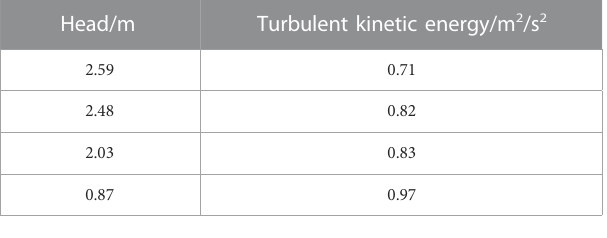
TABLE 1 The change of turbulent kinetic energy under different characteristic head conditions.